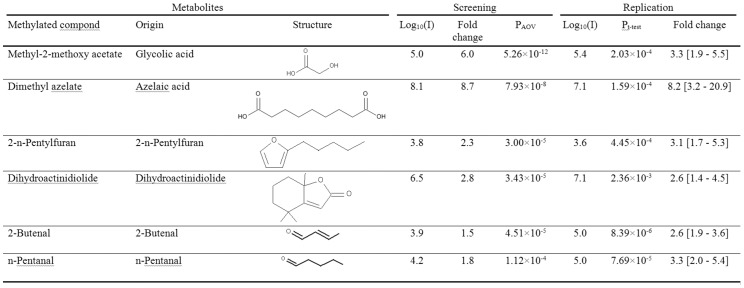
Metabolites identified as consistently increased after ES in liver samples.The results of the screening stage are noted with the decadic logarithm of the peak area in the GC/MS denoted as Log10(I), the fold increase after ES and the p-value obtained from the analysis of variance including the patient as covariate denoted as PAOV. For the replication series, results of the paired t-test are denoted as Pt-test. Nominal p-values are given for all analyses.